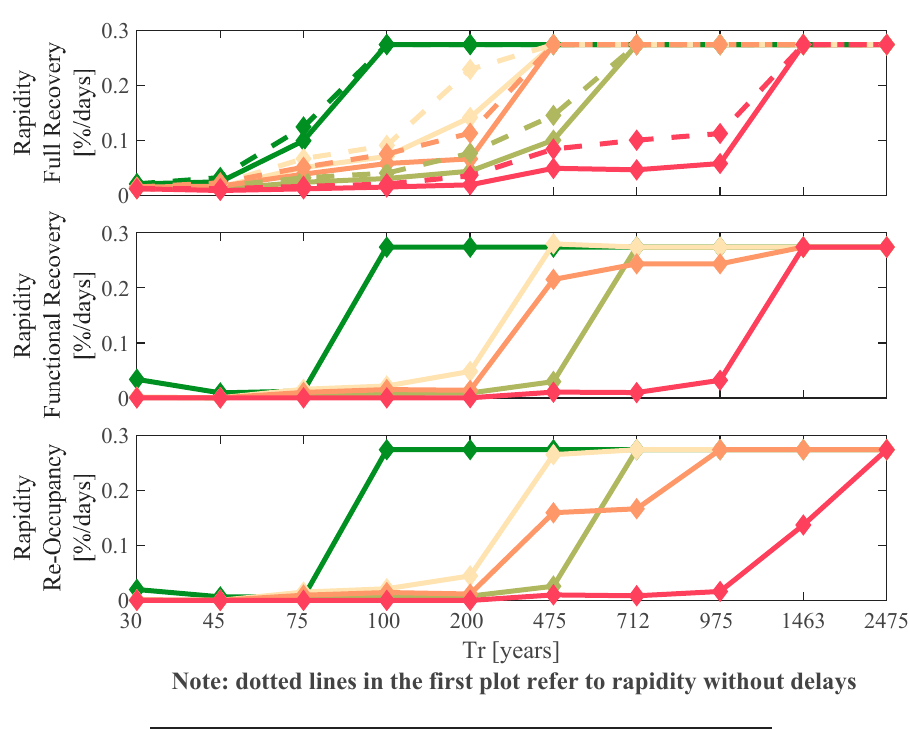
Figure 11. Rapidity of the case study school building (A0) and retrofitting alternatives.